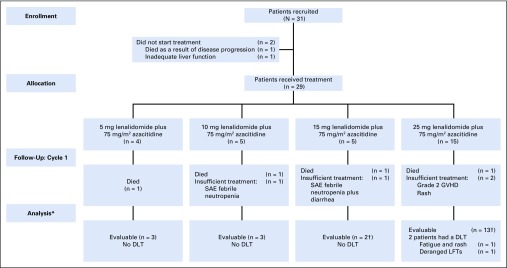
Flow diagram of participants summarizing patient flow from trial entry, detailing evaluability for maximum tolerated dose (MTD) determination. (*) A patient was considered to be evaluable for MTD determination if they received all seven doses of azacitidine and at least 80% (17 days) of lenalidomide in cycle 1 of treatment; those who withdrew/died for reasons that were deemed to be non–treatment related in cycle 1 were classed as inevaluable and were replaced accordingly. (†) One patient was treated incorrectly with the higher dose (25 mg lenalidomide plus 75 mg/m2 azacitidine) for cycle 1 rather than 15 mg lenalidomide plus 75 mg/m2 azacitidine and so was included in the higher dose level for the analysis. The patient reverted to the correct assigned dose level for the proceeding cycles. DLT, dose-limiting toxicity; GVHD, graft-versus-host disease; LFT, liver function tests; SAE, serious adverse event.